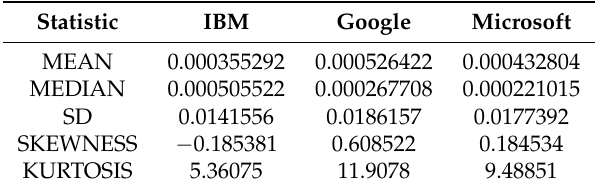
Table 1. Descriptive statistics for daily adjusted-return series.